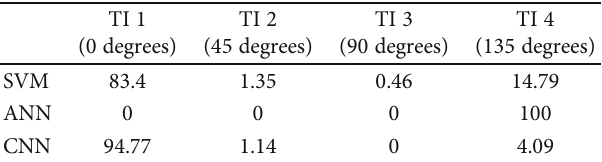
Table 6: TI probabilities from the three classi fi cation models to the reference fi eld ’ s observed production.